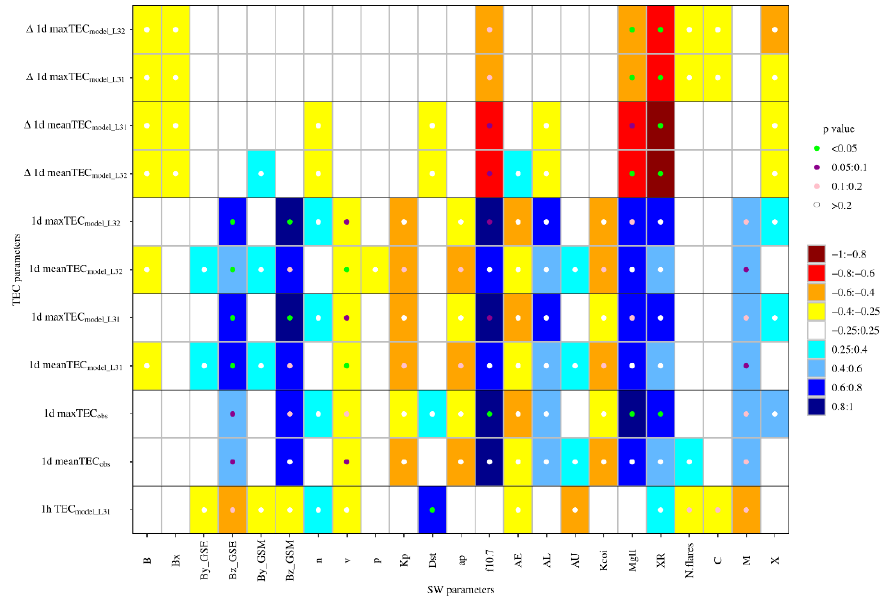
Figure 6. Correlation coefficients between TEC parameters and SWp on the monthly time scale. TEC parameters ( Y -axis bottom up): forecasted TEC 1 h, forecasted and observed 1 d mean and 1 d max series, 1 d mean and 1 d max ∆ TEC series; SWps are along the X -axis; r values are shown as coloured tiles and p values are shown as coloured dots.